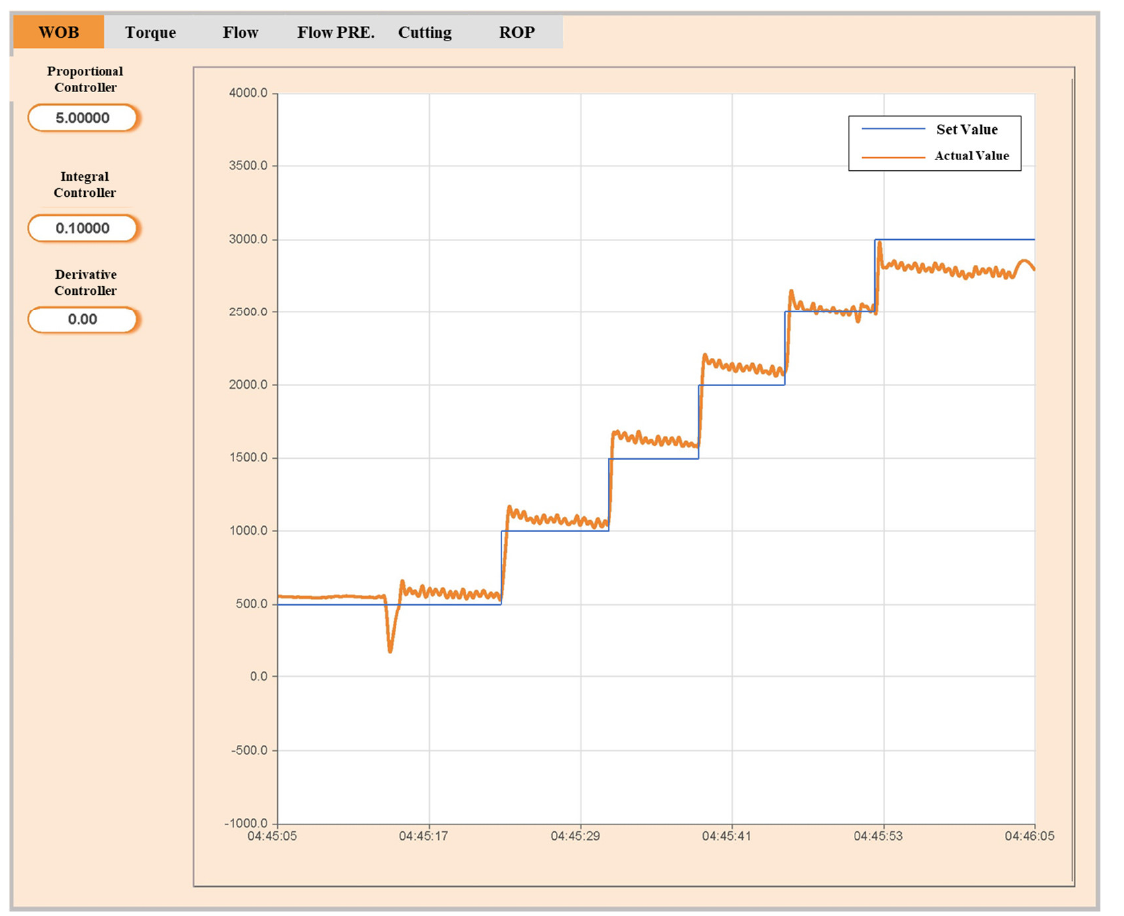
Figure 8. Real-time WOB curve in GUI for different WOB settings after PID control parameters are adjusted.